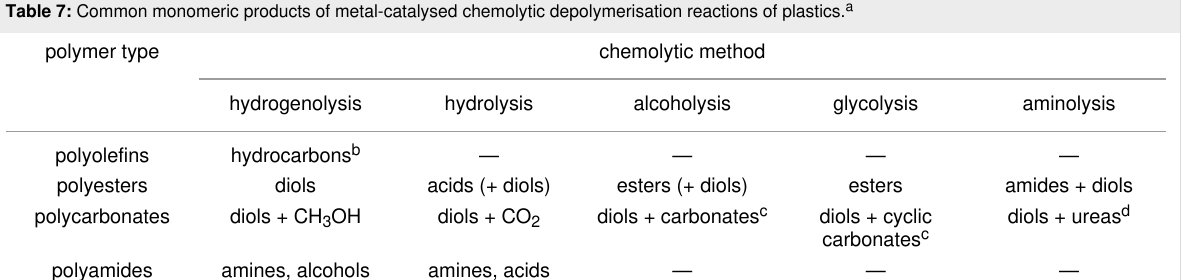
Table 7: Common monomeric products of metal-catalysed chemolytic depolymerisation reactions of plastics. a